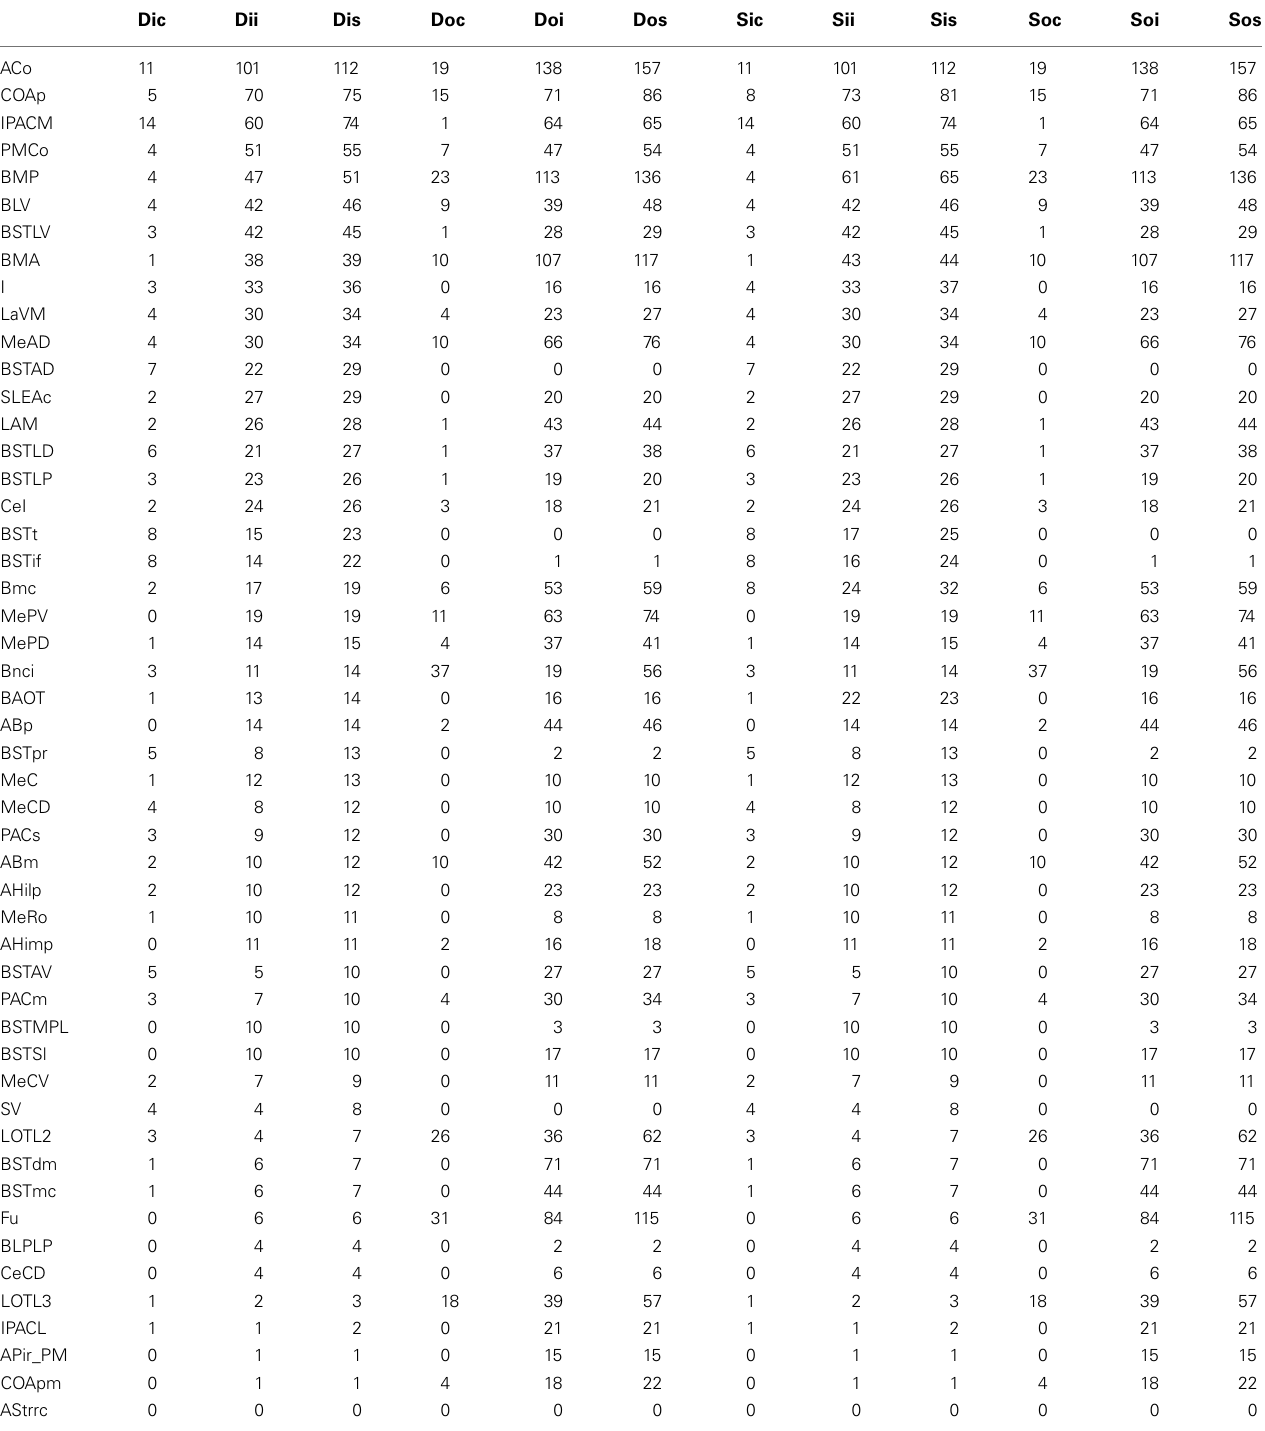
Table 7 | Extrinsic bilateral inputs and outputs of all regions of the condensed intrinsic amygdala